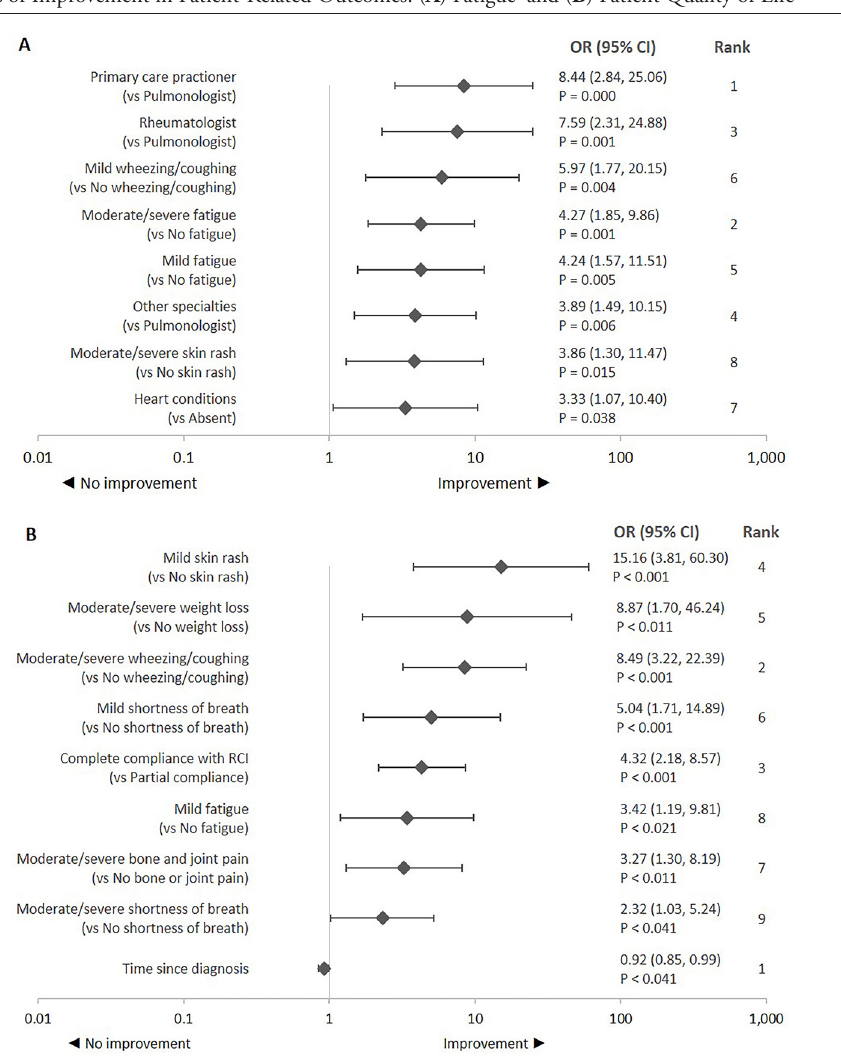
Figure 3. Predictors of Improvement in Patient-Related Outcomes: ( A ) Fatigue a and ( B ) Patient Quality of Life